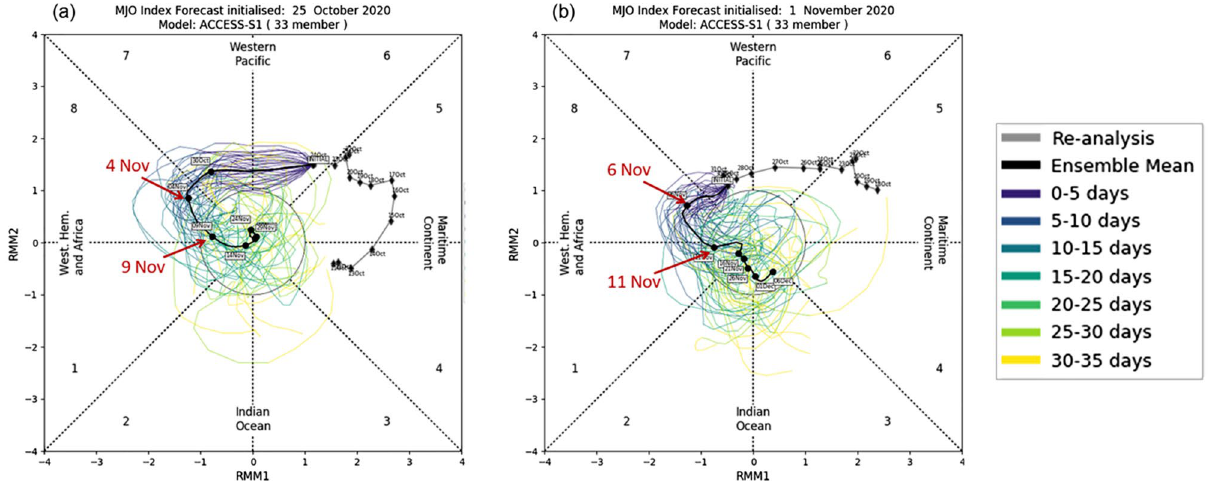
Figure 11. ACCESS-S1 forecasts for the MJO in November 2020. Forecasts were initialised on ( a ) 25 October and ( b ) 1 November of 2020. A 33-member burst ensemble was used for these diagrams. The grey line indicates the observed trajectory of MJO over the 15 days leading up to the forecast initialisation date, and the thick black line indicates the ensemble mean forecast. The thin coloured lines indicate the ensemble member forecasts, and the different colours denote the different verification windows as shown by the legend. The ensemble mean forecasts shown in solid black lines are to be compared to the green line in Fig. 8.